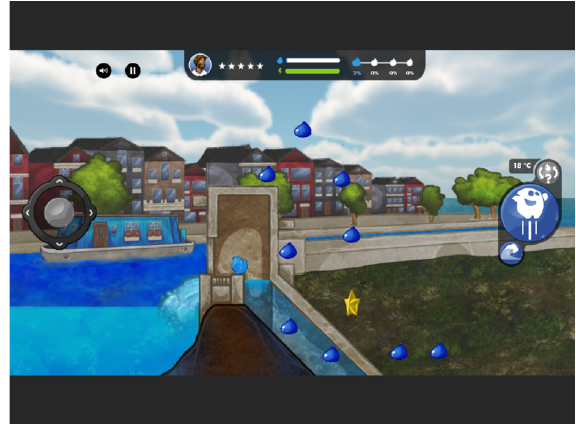
Figure 4. Players learn about geography through the background and foreground of the game.